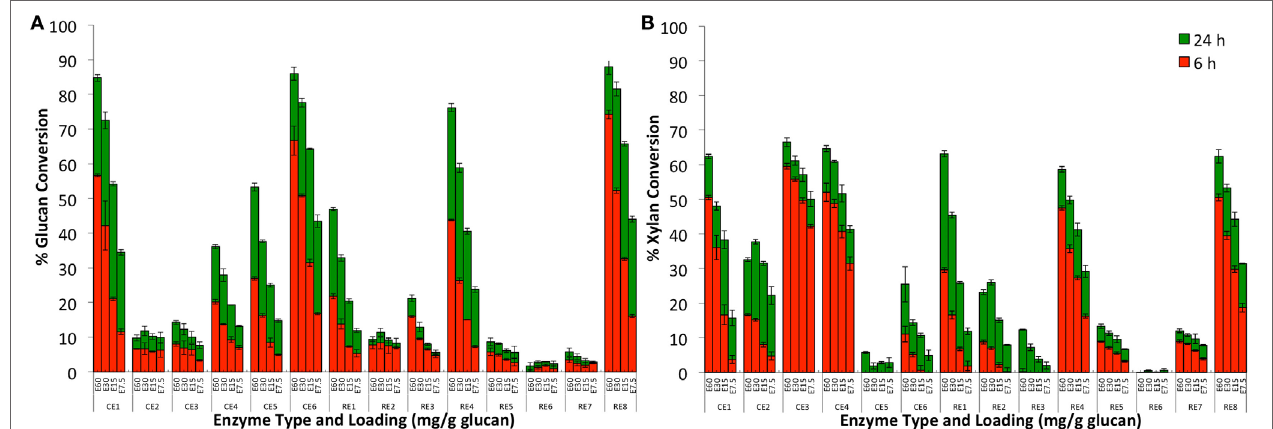
FigUre 1 | glucan-to-glucose (a) and xylan-to-xylose (B) percent conversion for aFeX-treated corn stover after 6 (red) and 24 (green) hours of hydrolysis using individual commercial (ce1–ce6) and research (re1–re8) grade enzymes . Four total protein loadings were employed in each case, namely, 60 (E60), 30 (E30), 15 (E15), and 7.5 (E7.5) mg total protein per g